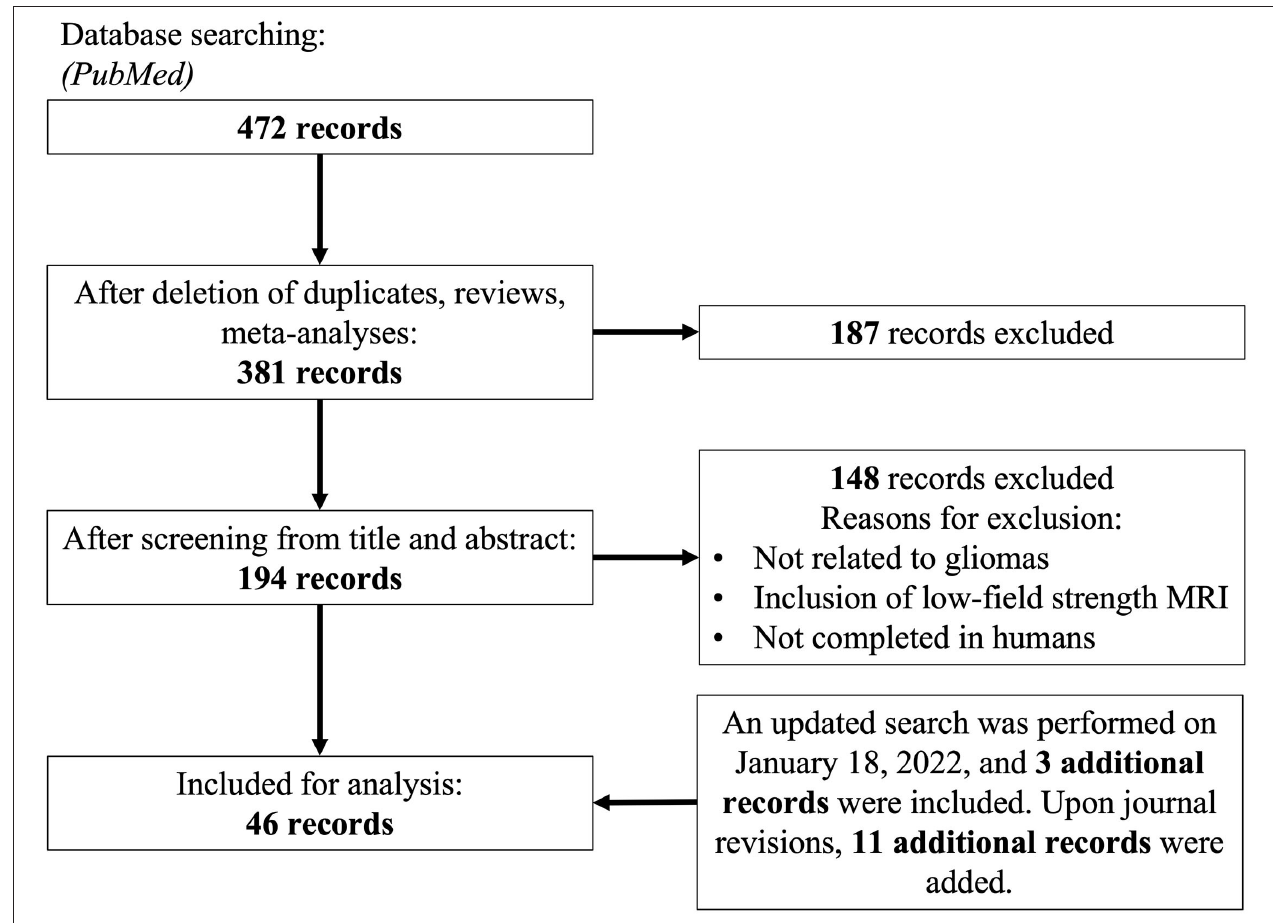
FIGURE 2 | PRISMA diagram for search